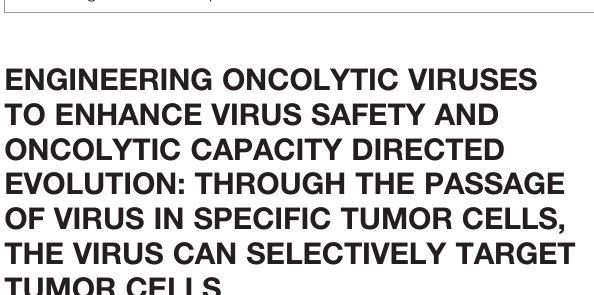
FIGURE 2 | Important immune and apoptotic pathways during SVA infection. Upon SVA delivery into the body by either intravenous or local injection, SVA fi rst enters the cell by recognizing the speci fi c receptor TEM8.SVA uncoating releases the viral genome into the cell, which is immediately translated and processed into the corresponding viral proteins. Among the proteins produced, 3Cpro promotes the cleavage of the important subunit p65 of NF- k B, leading to a decrease in NF- k B transcriptional activity and, as a consequence, induction of apoptosis. A different protein, 2C, interacts with the C-terminal region of Bcl-xL, which interferes with the interaction between Bcl-xL and Bax, increases the level of Bax in the mitochondria, and induces apoptosis. 3Cpro can also induce cell apoptosis through intrinsic and extrinsic death pathways. The speci fi c mechanism remains to be studied. In porcine cells, 3Cpro can also directly lyse GSDMD and induce pyroptosis. SVA can induce autophagy through PERK pathway and ATF6 pathway after infecting cells. The 3Cpro protein can inhibit selective autophagy by cleaving the autophagy receptor SQSTM1/p62. Cells that die after being infected by SVA will release large amounts of TAAs, DAMP, and PAMP, stimulating a wider range of cellular